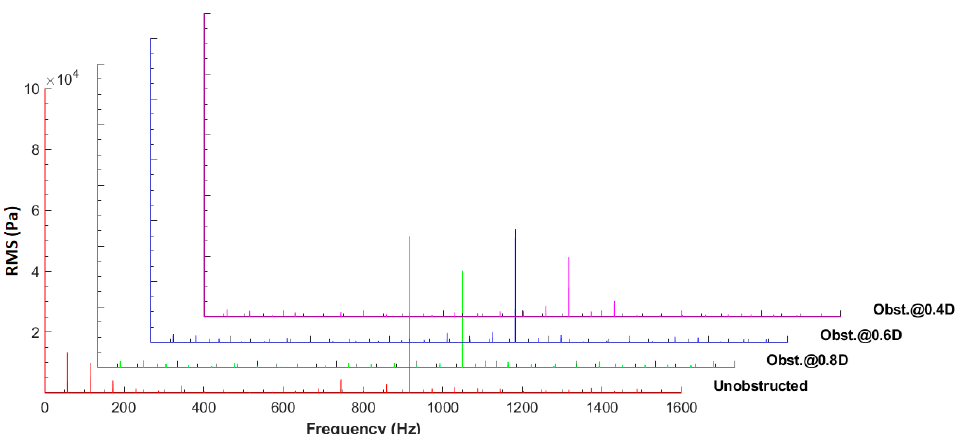
Figure 16. Frequency spectra in the inertial reference frame (monitor point E2) for different rotor blockage positions.